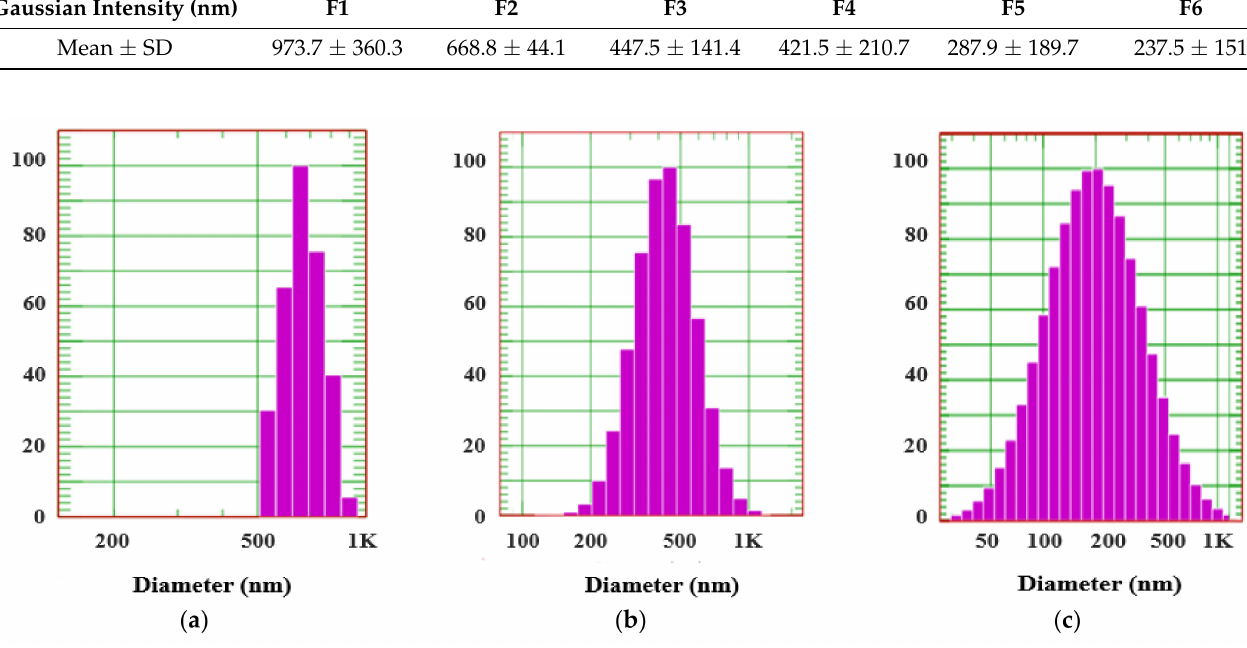
Figure 2. Particle size distribution of the self-assembled liquid crystalline nanoparticles; ( a ) F2 formulation (lamellar structure), ( b ) F3 formulation (hexagonal structure), ( c ) F6 formulation (cubic